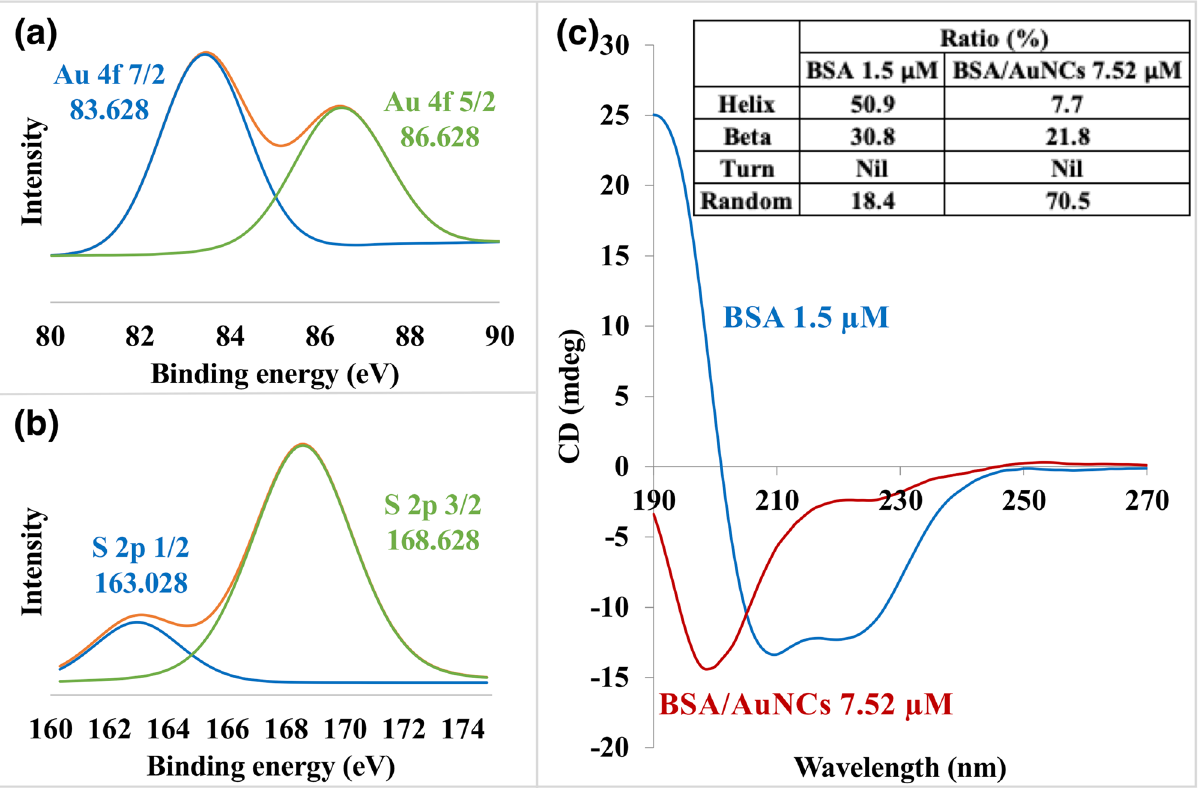
Figure 2. Characterization of BSA/AuNCs. Representative X-ray photoelectron spectroscopy (XPS) spectra of ( a ) Au 4f, ( b ) S 2p and ( c ) CD spectra of